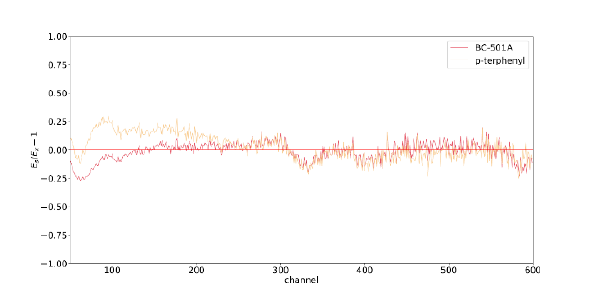
Fig. 10 E s /E x - 1 comparison of BC-501A and p-terphenyl with